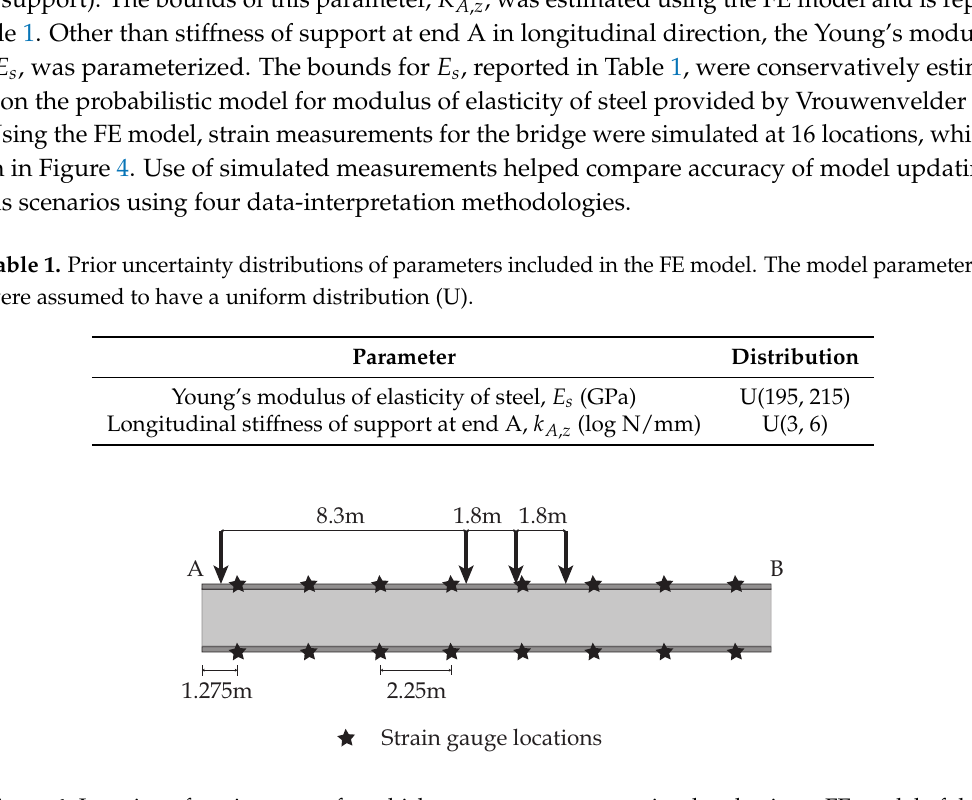
Figure 4. Location of strain gauges for which measurements were simulated using a FE model of the Ponneri